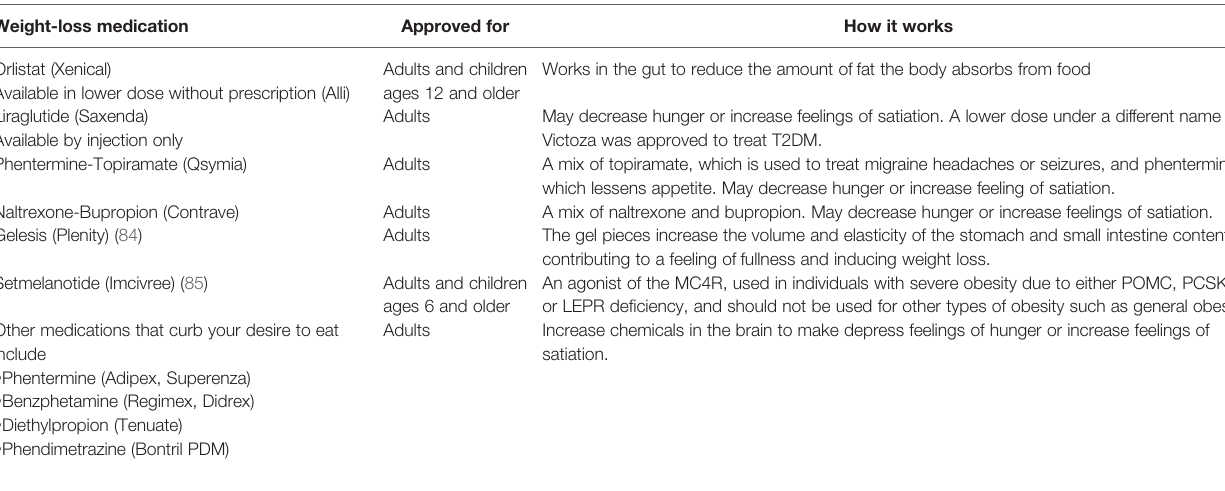
TABLE 1 | Prescription medications approved for obesity